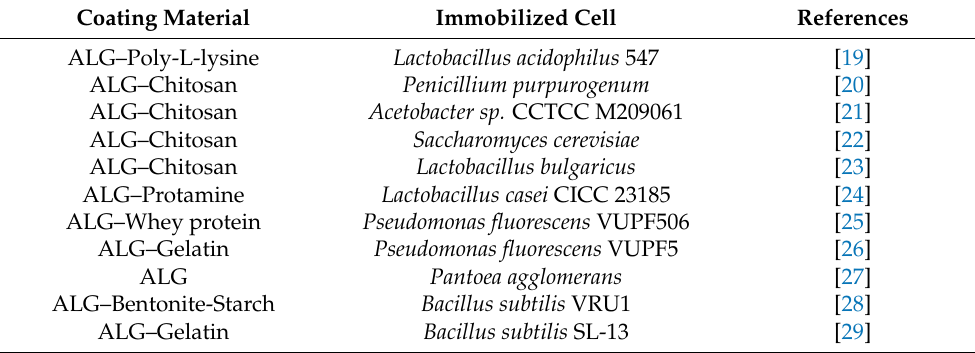
Table 1. Microbial immobilization in alginate capsules mixed with other coating materials.